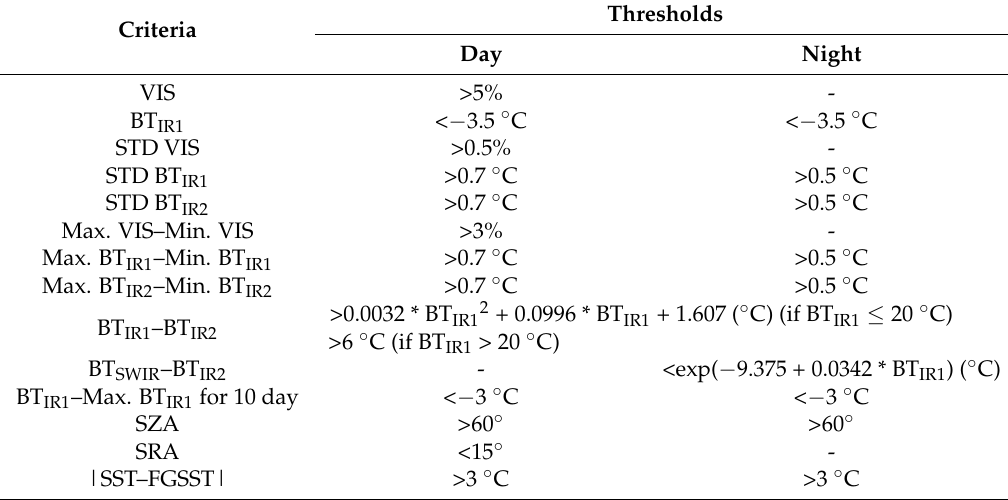
Table 2. List of criteria and thresholds for the removal of cloudy and cloud-contaminated pixels and pixels with inappropriate satellite zenith angle and sun reflection angle (VIS: Albedo of visible channel, BT IR1 : Brightness temperature of IR1 channel, BT IR2 : Brightness temperature of IR2